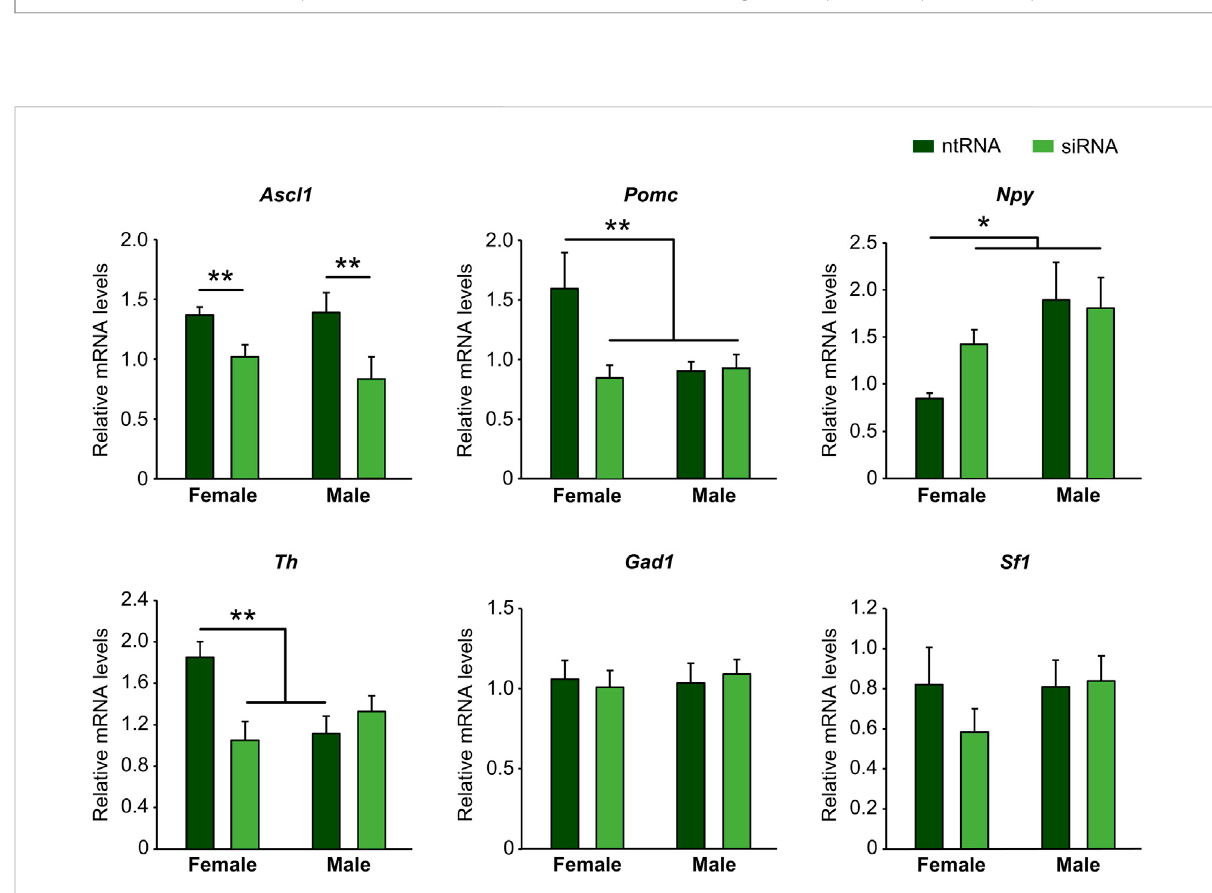
FIGURE 1 transfectedwithntRNAandGFPorsiRNAandGFPatthreeDIVfor18 h.Ngn3proteinexpression(red)wasdeterminedbyimmuno fl uorescence staining in transfected GFP+ neurons (green). Nuclei were stained with DAPI (blue). Arrowheads point to representative measured neuronal somas. (C) Quanti fi cation of fl uorescence intensity for Ngn3 expressed as corrected total cell fl uorescence (CTCF).Kdm6a knockdown bysiRNA eliminated sex differences in Ngn3 protein expression by downregulating the proneural factor only in female-derived neurons. Data are mean ± SEM. n = 40 – 100 neurons from four independent cultures for each sex and treatment. ns, not signi fi cant; * p < 0.05; ** p < 0.01; **** p < 0.0001.